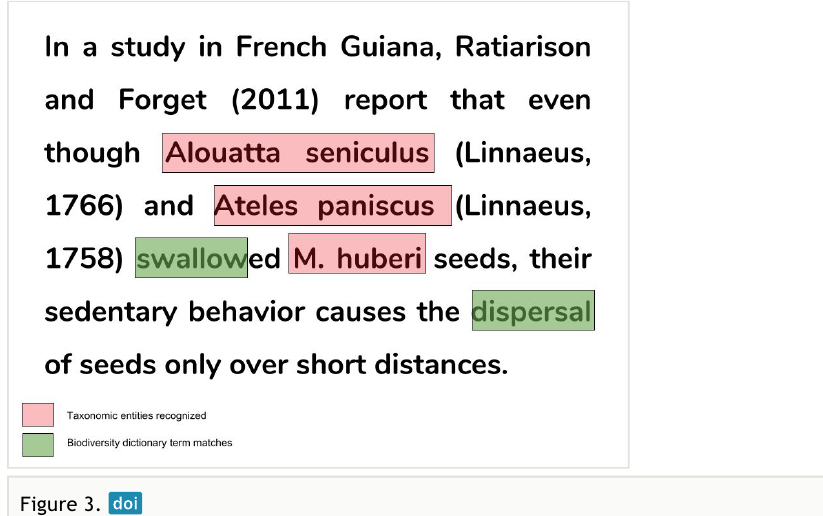
Example of one text snippet resulting from running Biodiversity Observations Miner with O'Farrill et al. (2013) as input. This text snippet ( i.e. biodiversity observation ) contains data about a frugivory interaction between plants and animals. Here, biodiversity data comes from the description of the monkeys Alouatta seniculus and Ateles paniscus being frugivores of M. huberi fruits. The terms "swallow" and "dispersal" were part of the frugivory biodiversity dictionary included in BOM. Red boxes highlight the taxonomical entities recognised using the Global Names Architecture API implemented with the taxize (Chamberlain and Szöcs 2013) R package. The green boxes show the matches of frugivory dictionary terms within the text